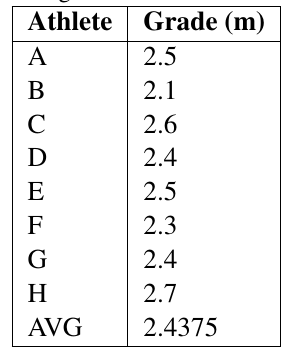
Table 1 Training results of some Chinese athletes.